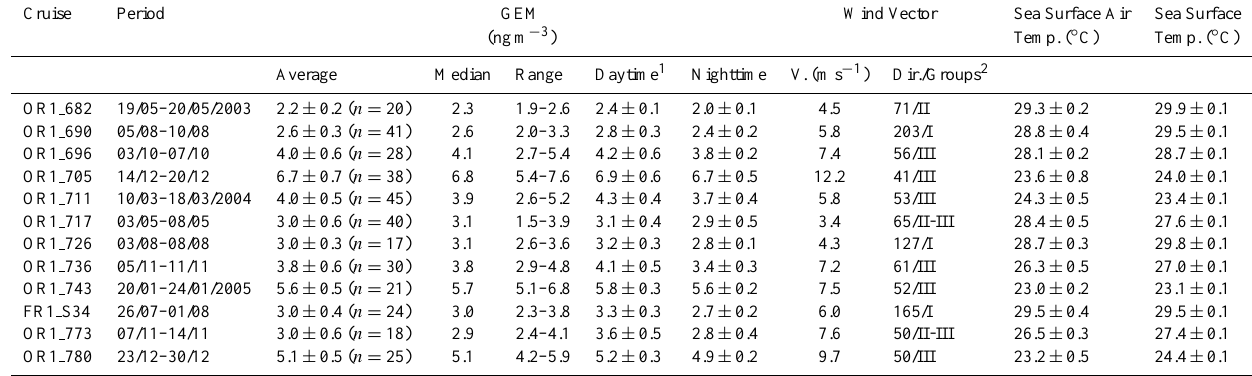
Table 1. Statistical summary of GEM concentrations with environmental variables in the northern SCS obtained during the study period from 2003 to 2005.